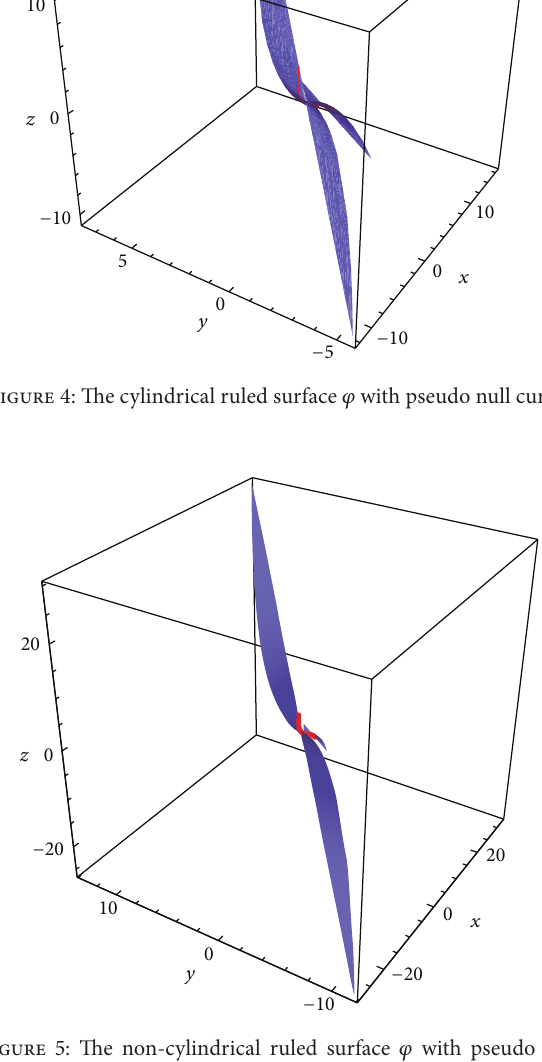
Figure 5: The non-cylindrical ruled surface 𝜑 with pseudo null